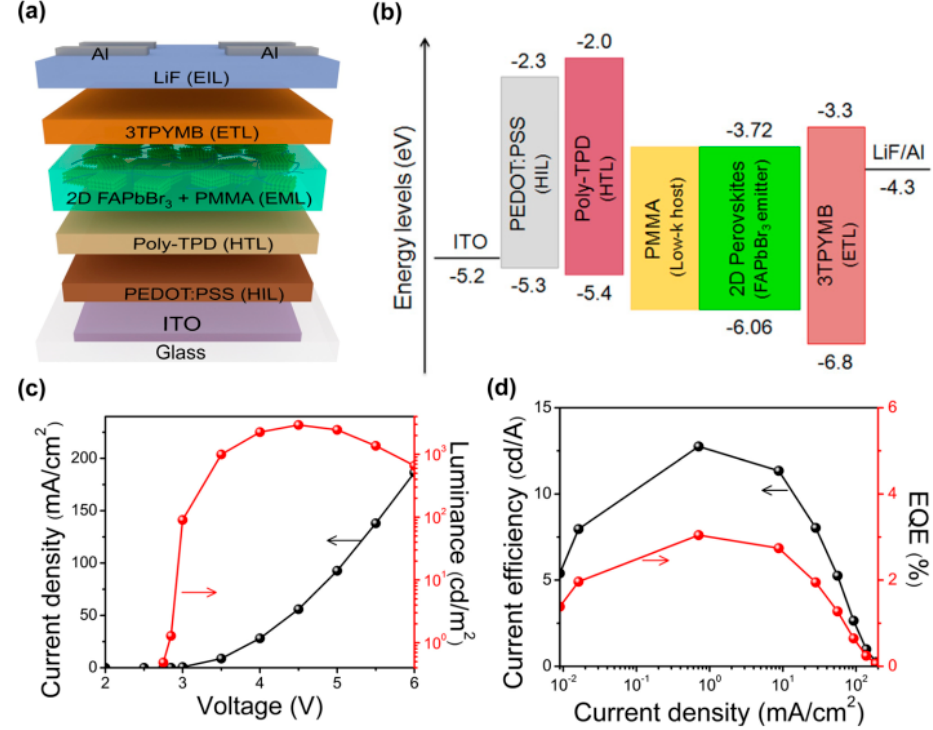
Figure 8. Properties for LEDs based on 2D FAPbBr 3 perovskites. ( a ) The LED structure; ( b ) Energy levels of materials; ( c ) Current density as well as luminance; ( d ) Current efficiency as well as EQE. Adapted from [128], with permission from © 2017 American Chemical